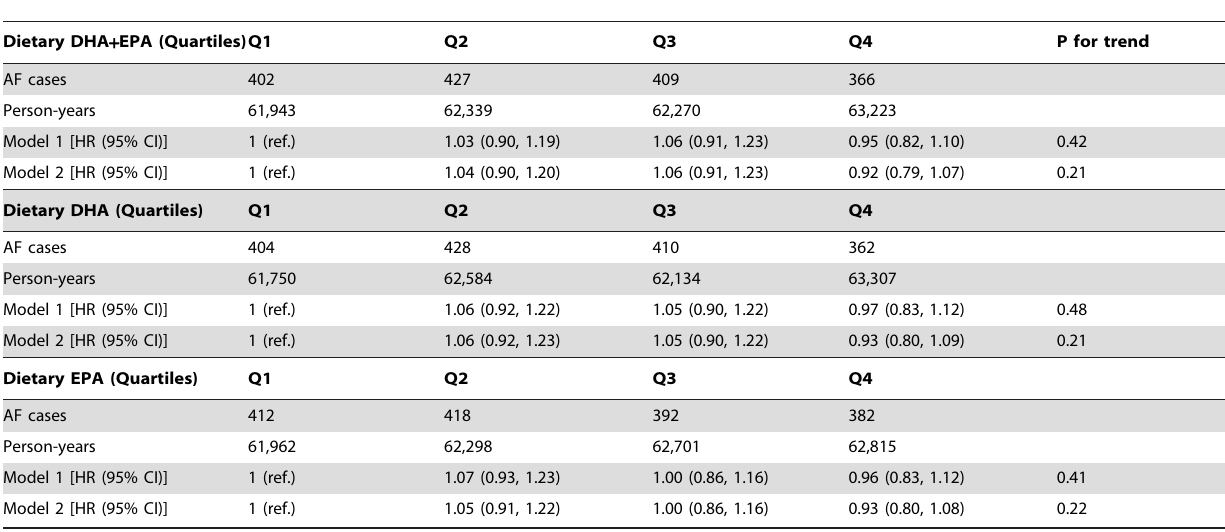
Table 3. Hazard ratios (95% confidence interval) of atrial fibrillation by categories of DHA + EPA intake, ARIC, 1987–2008.